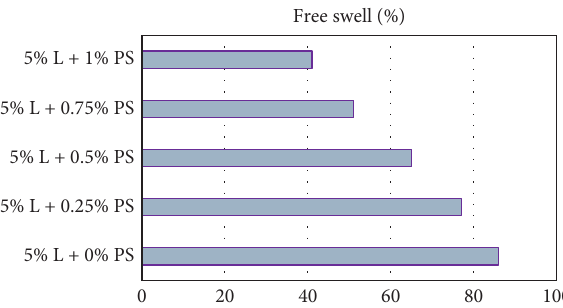
Figure 6: Variation in free swell with plastic